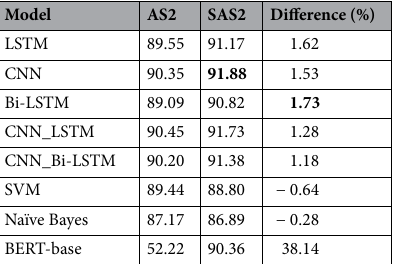
Table 6. Accuracy (%) of the algorithms trained with the AS2 and SAS2 datasets and the difference (%) of the accuracy in these two cases. Significant values are in bold.